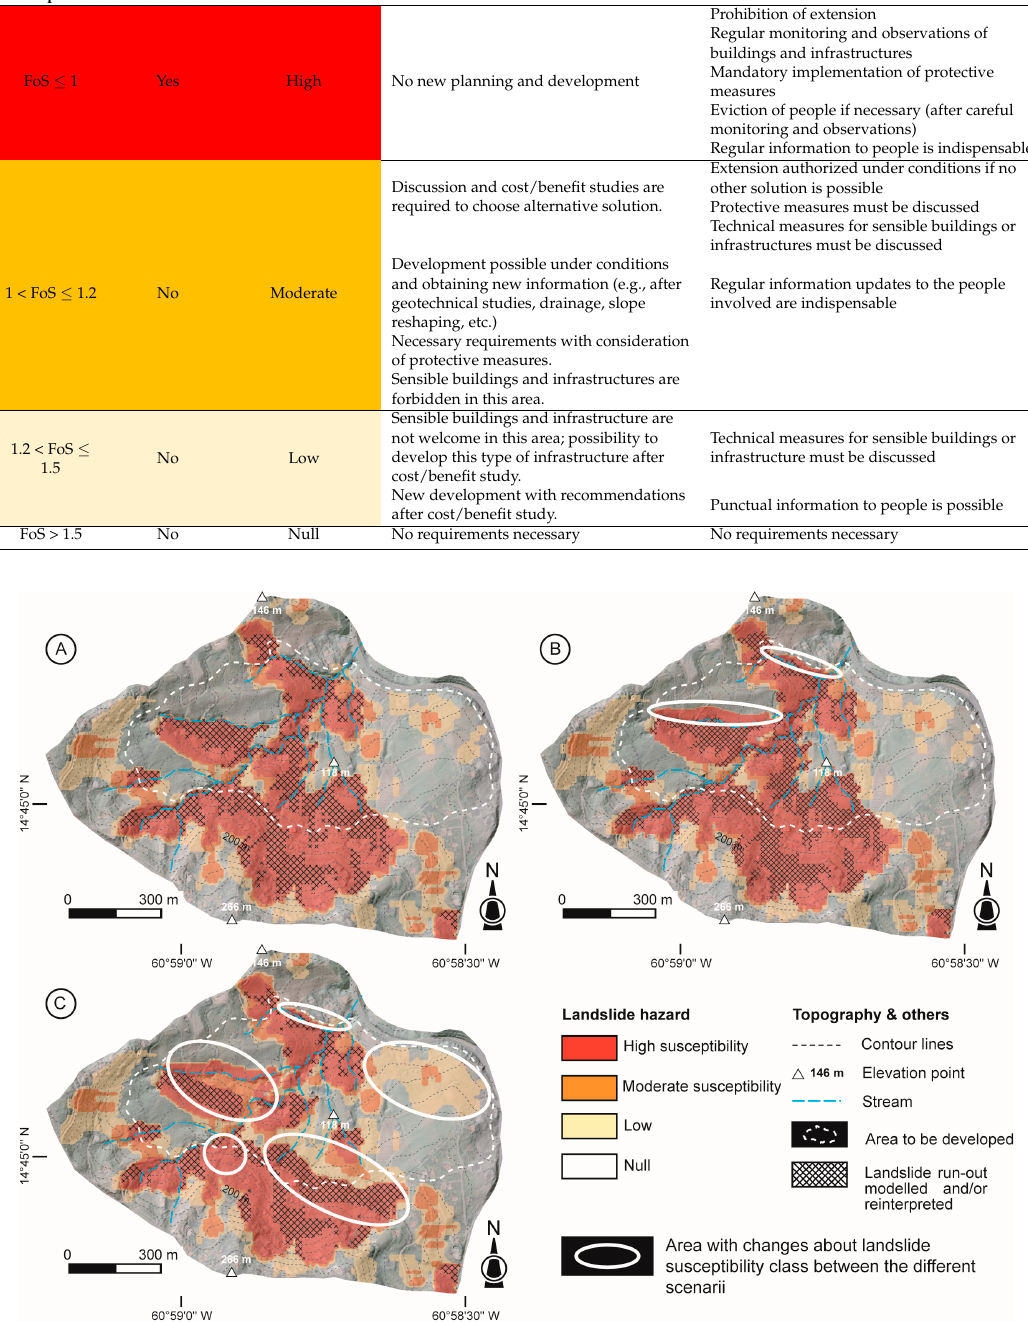
Figure 14. ( A ) Landslide advanced susceptibility map produced by models (not taking into account expert reasoning in addition); ( B ) landslide advanced susceptibility map produced by models and expert reasoning for Scenario 1 (rising of GWL); ( C ) landslide advanced susceptibility map produced by models and expert reasoning for Scenarios 2 & 3 (rising of GWL and anthropic works) (coordinates are expressed in Lat/Long; projection WGS84 UTM 20N—EPSG 32620).